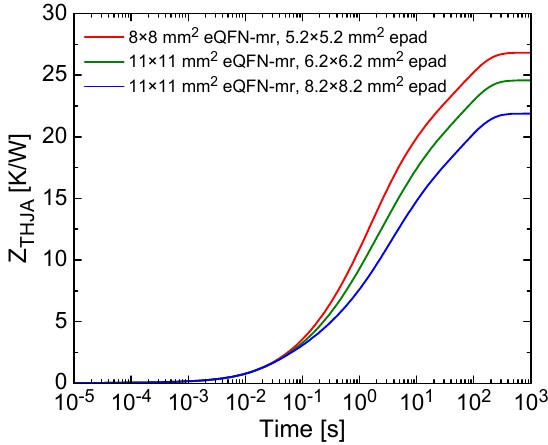
Figure 9. Thermal impedance Z THJA vs. time of various dual-row eQFN-mr packages sharing a die size of 3 × 3 mm 2 .